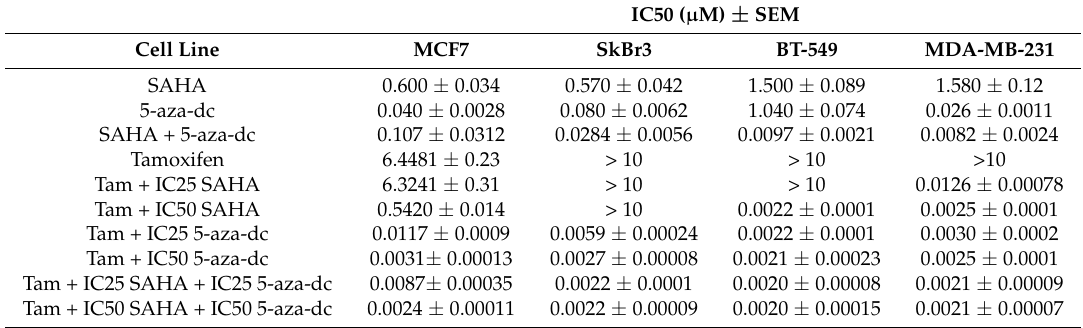
Table 3. IC50 values of SAHA and/or 5-aza-dc and their combination with TAM against four breast cancer cell